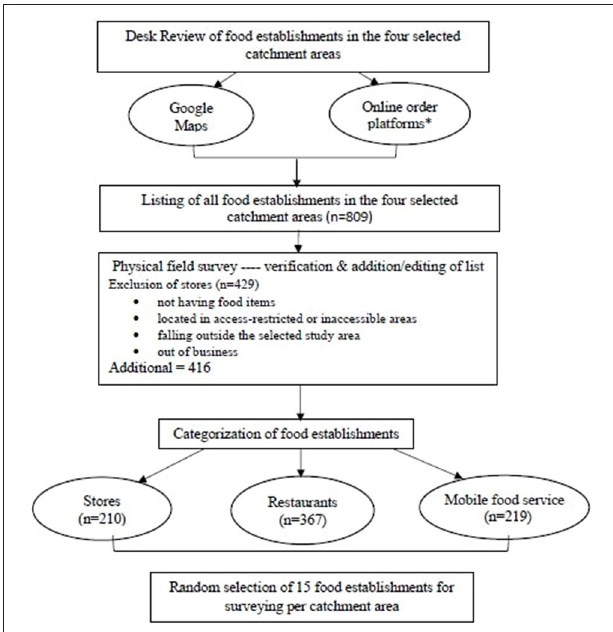
FIGURE 1 | Study sampling. *Online order platforms included Swiggy, Zomato, and Food